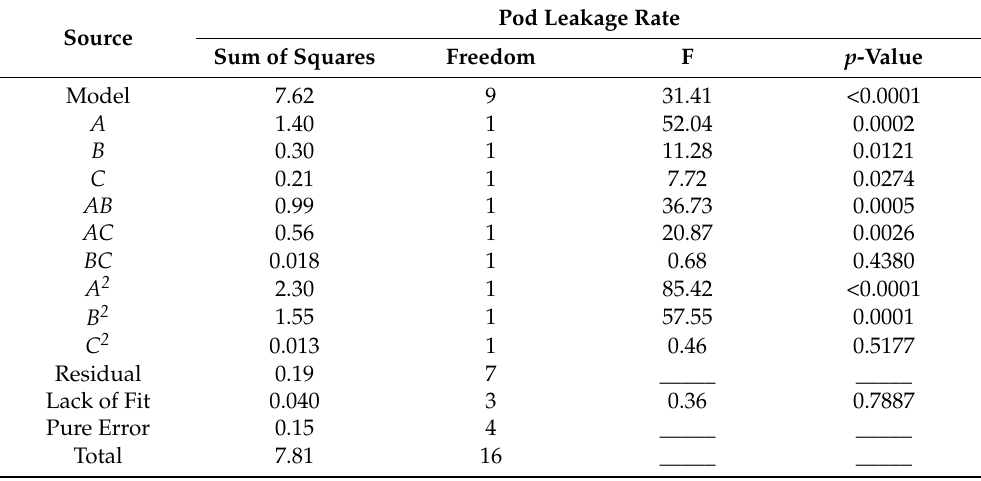
Table 7. Pod leakage rate analysis of